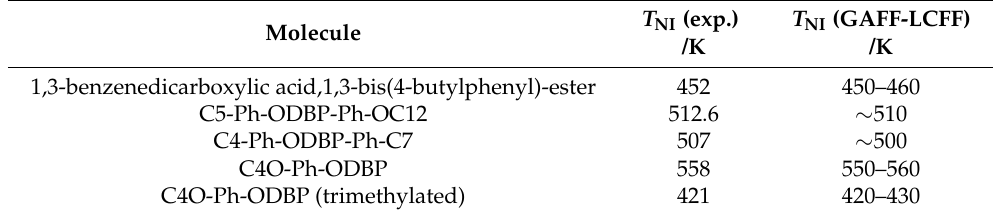
Figure 3. Structures of the five mesogens used in Table 1 (top to bottom: 1,3-benzenedicarboxylic acid,1,3-bis(4-butylphenyl)-ester, C5-Ph-ODBP-Ph-OC12, C4-Ph-ODBP-Ph-C7, C4O-Ph-ODBP, and C4O-Ph-ODBP (trimethylated)). Table 1. Experimental and simulated clearing points for a series of liquid crystalline systems using GAFF-LCFF modifications [28,31] relative to the GAFF force field